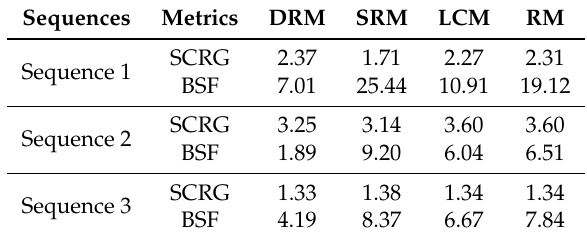
Table 2. Average scores of the procedures of the proposed